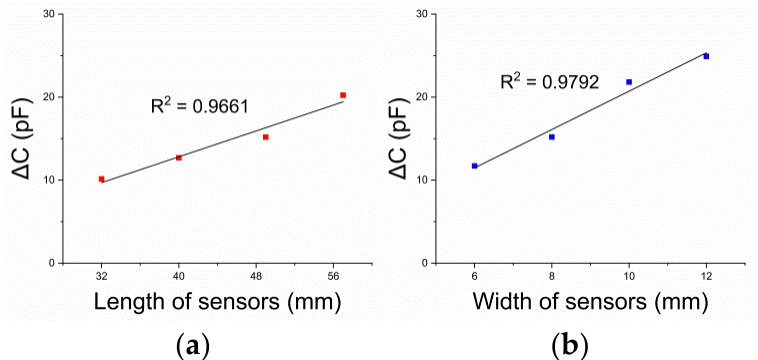
Figure 8. Full-scale output with ( a ) different lengths and ( b ) different thicknesses of each sensor under 50% strain. FSO was represented in (pF) units to compare the change in capacitance with the dimensions of the sensors.